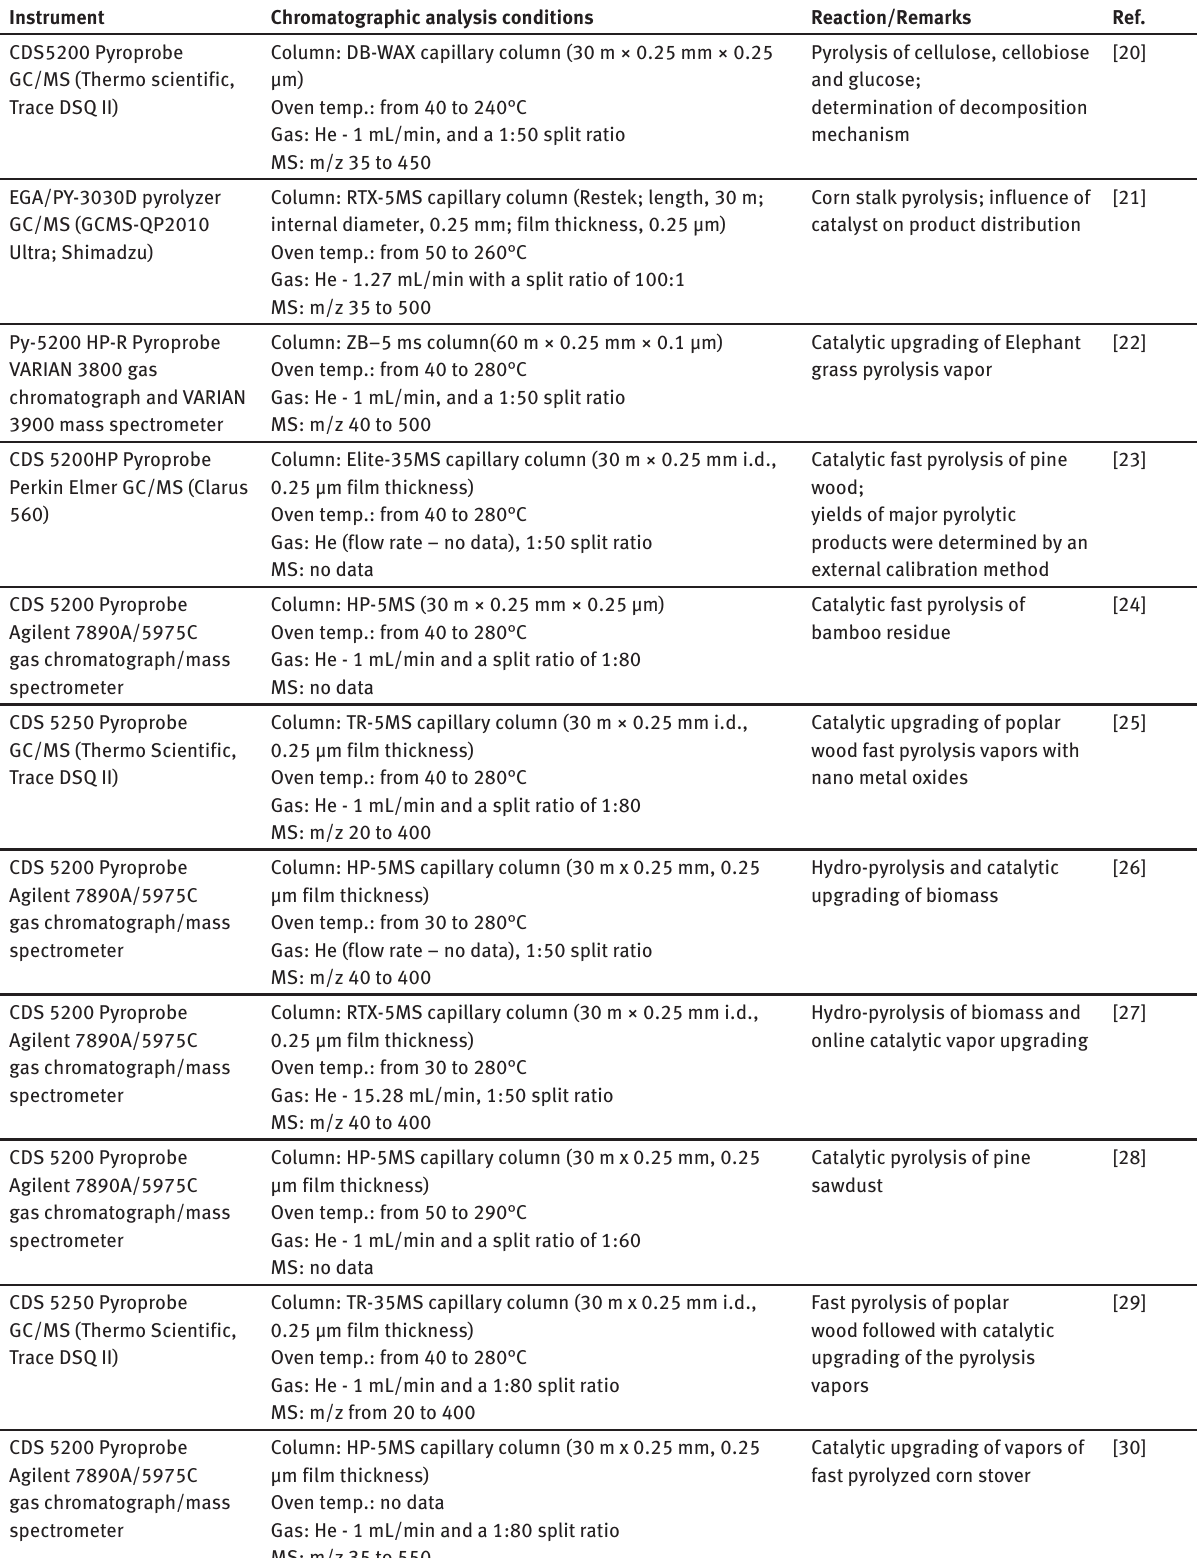
Table 1 Fast pyrolysis of lignocellulosic feedstock performed with the use of Py-GC/MS Instrument Chromatographic analysis